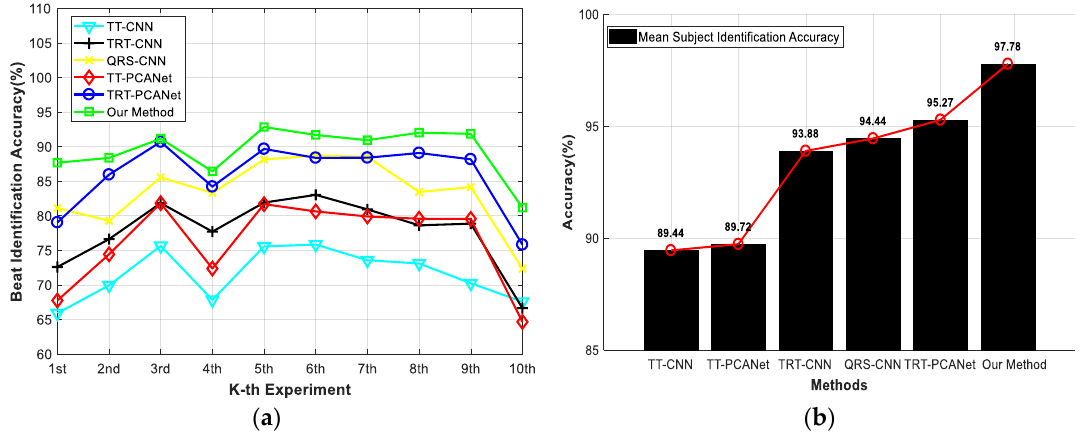
Figure 7. The accuracy comparison of the six identification methods. ( a ) Heartbeat identification comparison; ( b ) Comparison of mean subject identification accuracy of six methods.